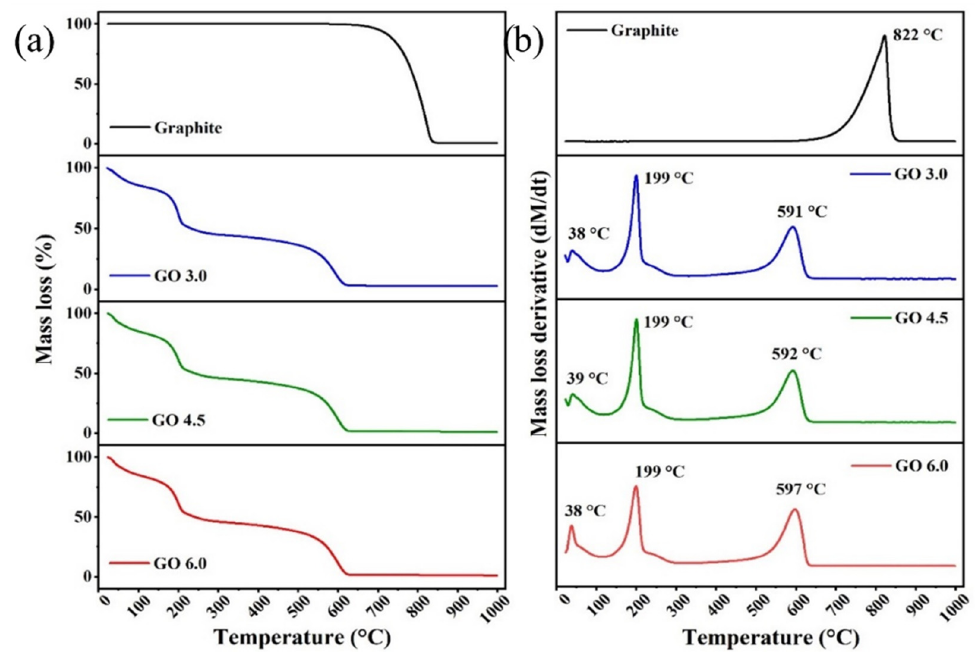
Figure 6. ( a ) TGA and ( b ) DTG curves of graphite, GrO 3.0 g, GrO 4.5 g and GrO 6.0 g samples. Table 3. Mass loss percentages in relation to different temperature ranges.